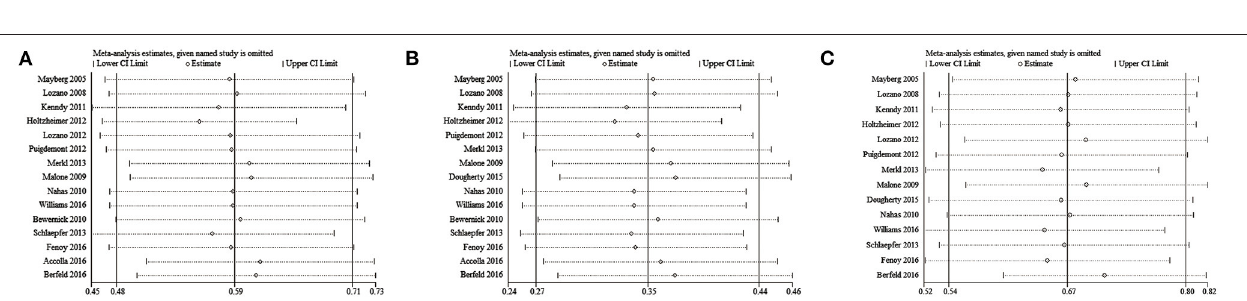
FIGURE 4 | Funnel plots with the pseudo 95% confidence limits. (A) Response rates; (B) Remission rates; (C) Adverse events rates.